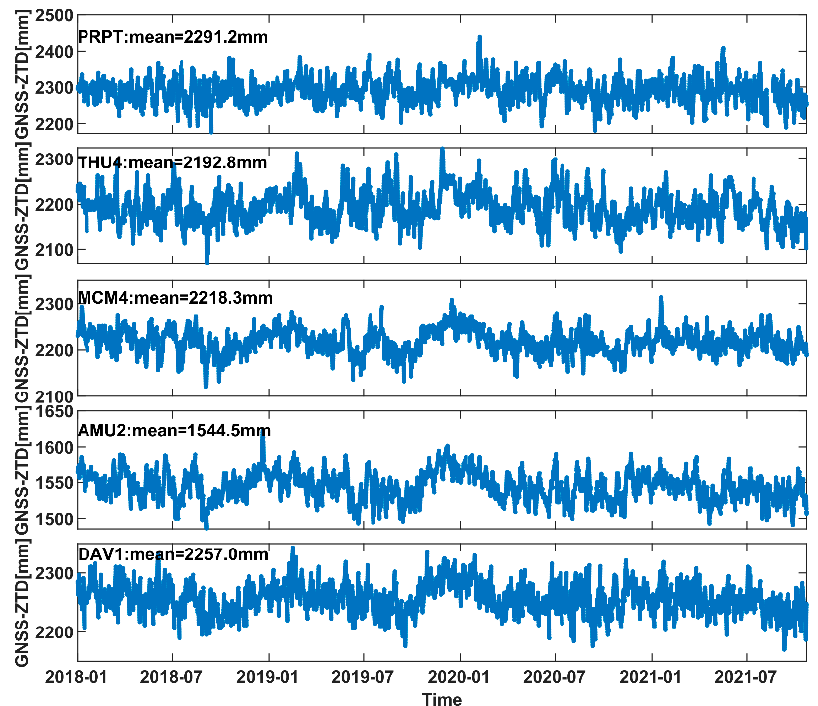
Figure 3. GNSS_ZTD series from 1 January 2018 to 23 October 2021 at PRPT, THU4, MCM4, AMU2 and DAV1 stations.